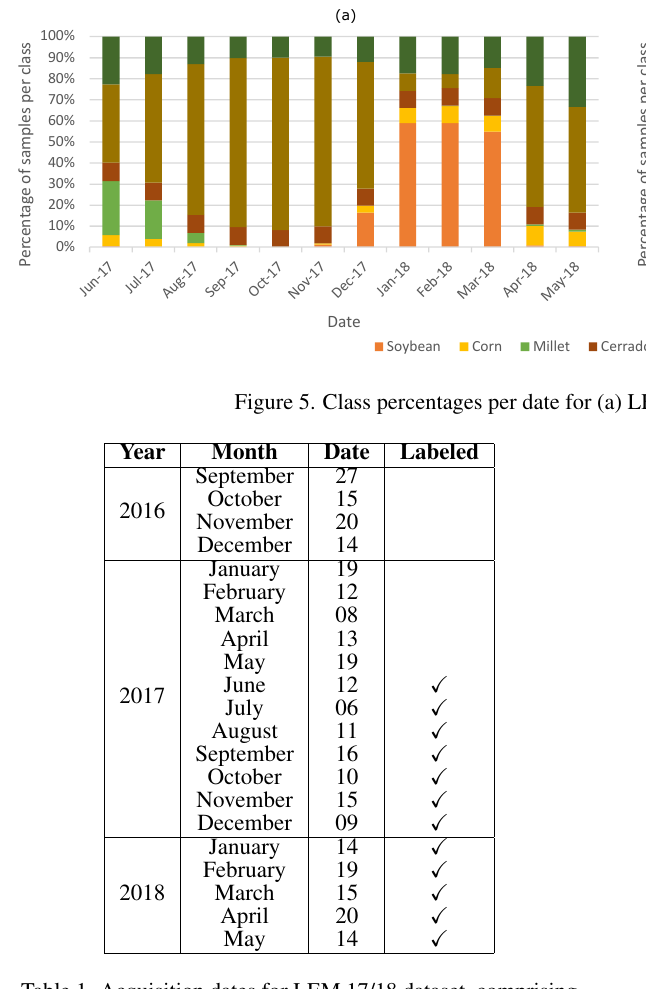
Table 1. Acquisition dates for LEM 17/18 dataset, comprising 21 images, whereby the ground truth is available for the last 12 dates. Table 2. Acquisition dates for LEM 19/20 dataset, comprising 23 images, whereby the ground truth is available for the last 12